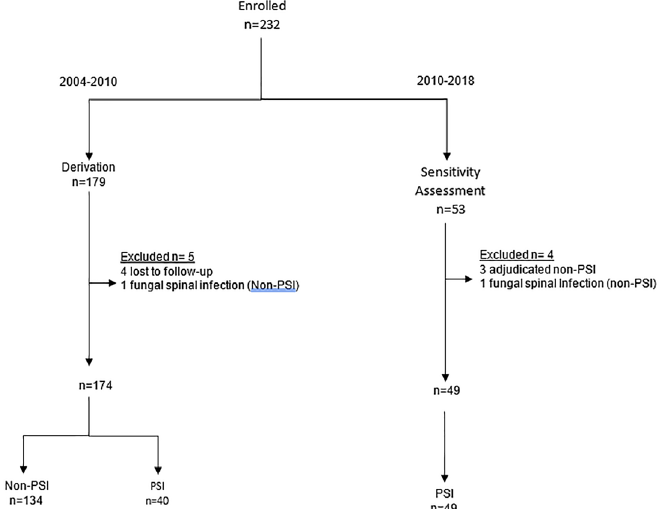
Figure 1. Flow chart of enrolled patients suspected of PSI (derivation) and PSI (sensitivity assessment) PSI, pyogenic spinal